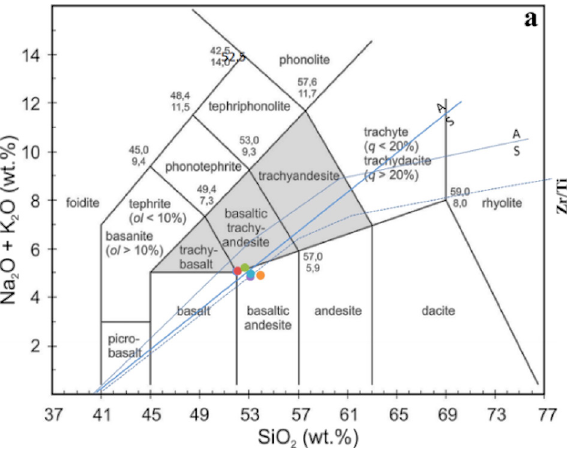
1973).Fig. 4. Geochemistry data: a – TAS (total alkalines versus silica) diagram (SiO alkaline discrimination diagrams (diagram